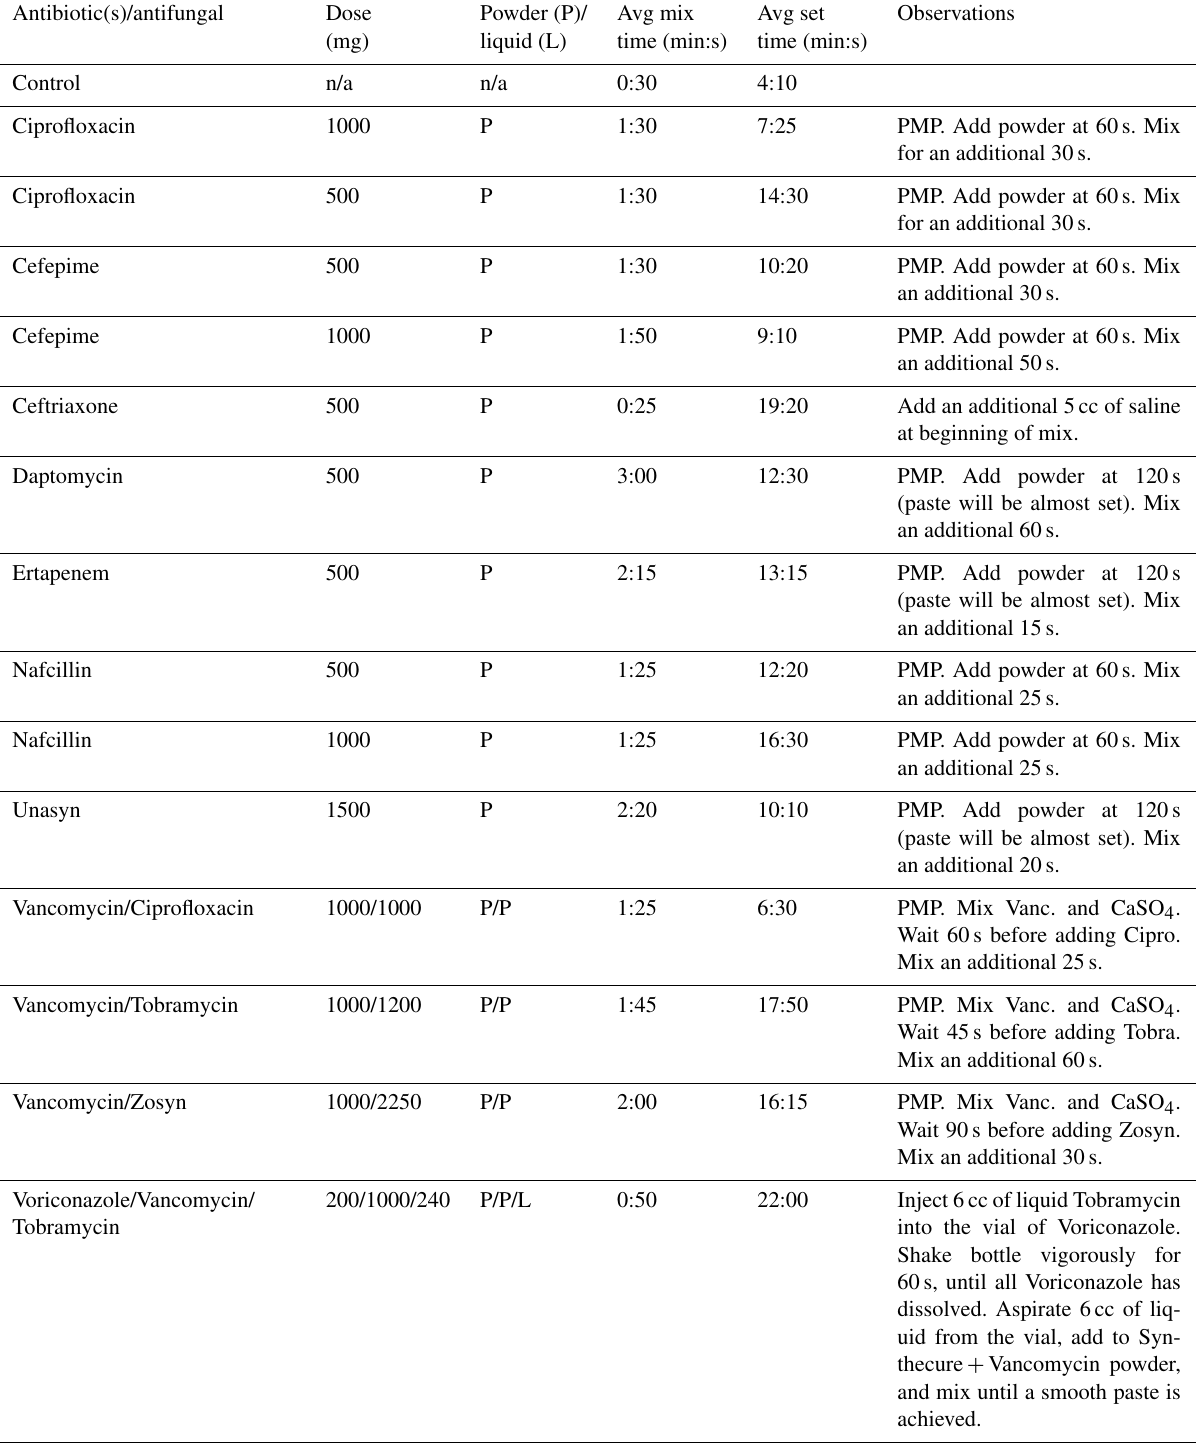
Table 2. Synthecure set times that required modified mixing techniques.